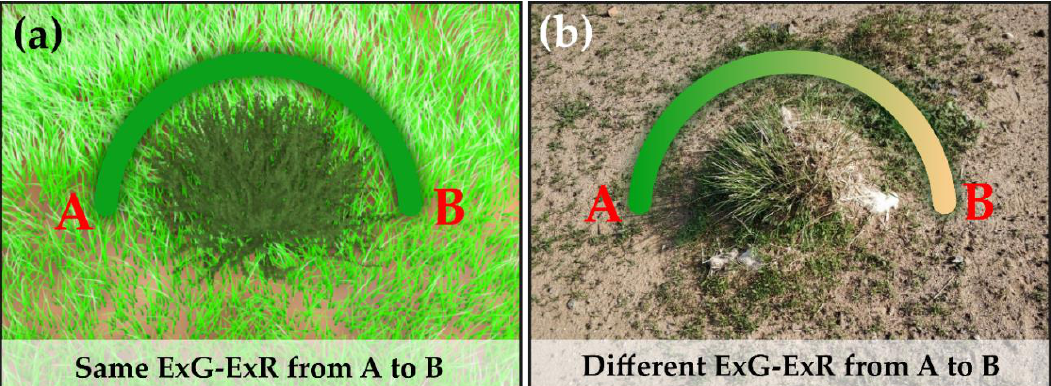
Figure 10. ExG-ExR directional heterogeneity of ( a ) the ideal model; ( b ) a practical situation of shrub-encroached grassland.